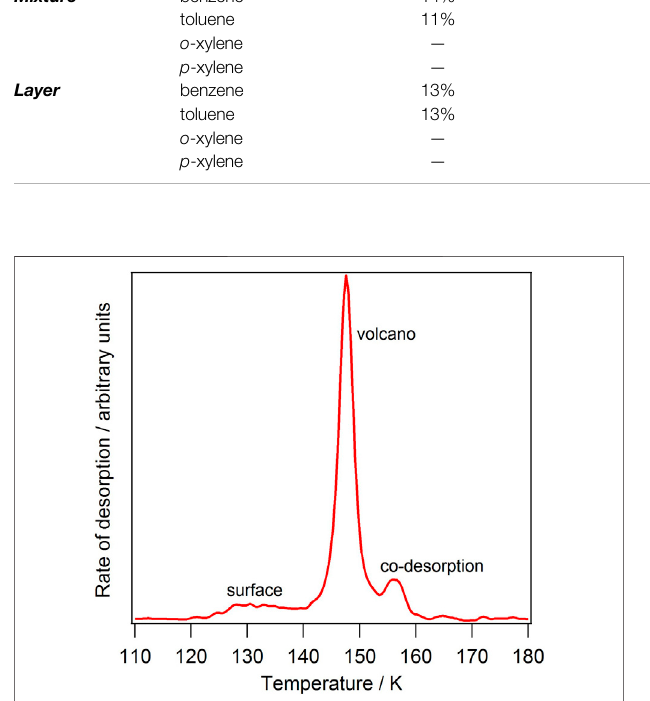
FIGURE 4 | TPD spectrum of 5 L m of benzene adsorbed in a layered con fi guration on top of 50 L m ASW, showing the assignment of each TPD